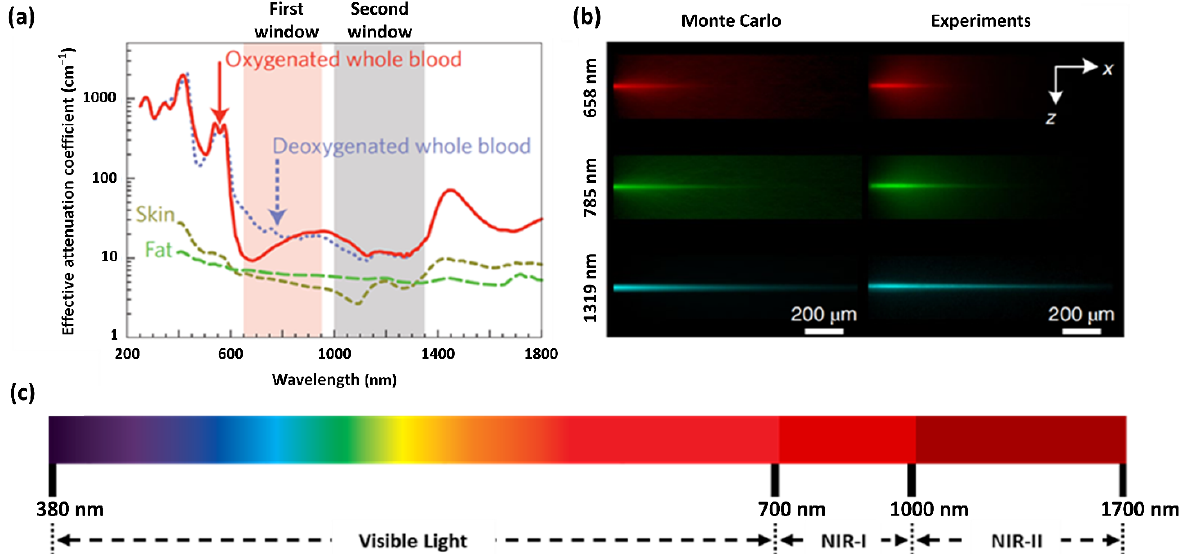
Figure 1. ( a ) Two optical windows showing the high transparency in biological tissues and fluids. Reprinted with permission from Ref. [31]. Copyright 2009, Springer Nature. ( b ) Photographs of experimental results in tissue penetration. Reprinted with permission from Ref. [43]. Copyright 2019, Springer Nature. ( c ) Spectral ranges for visible light, near-infrared (NIR)-I, and NIR-II showing the corresponding wavelengths.